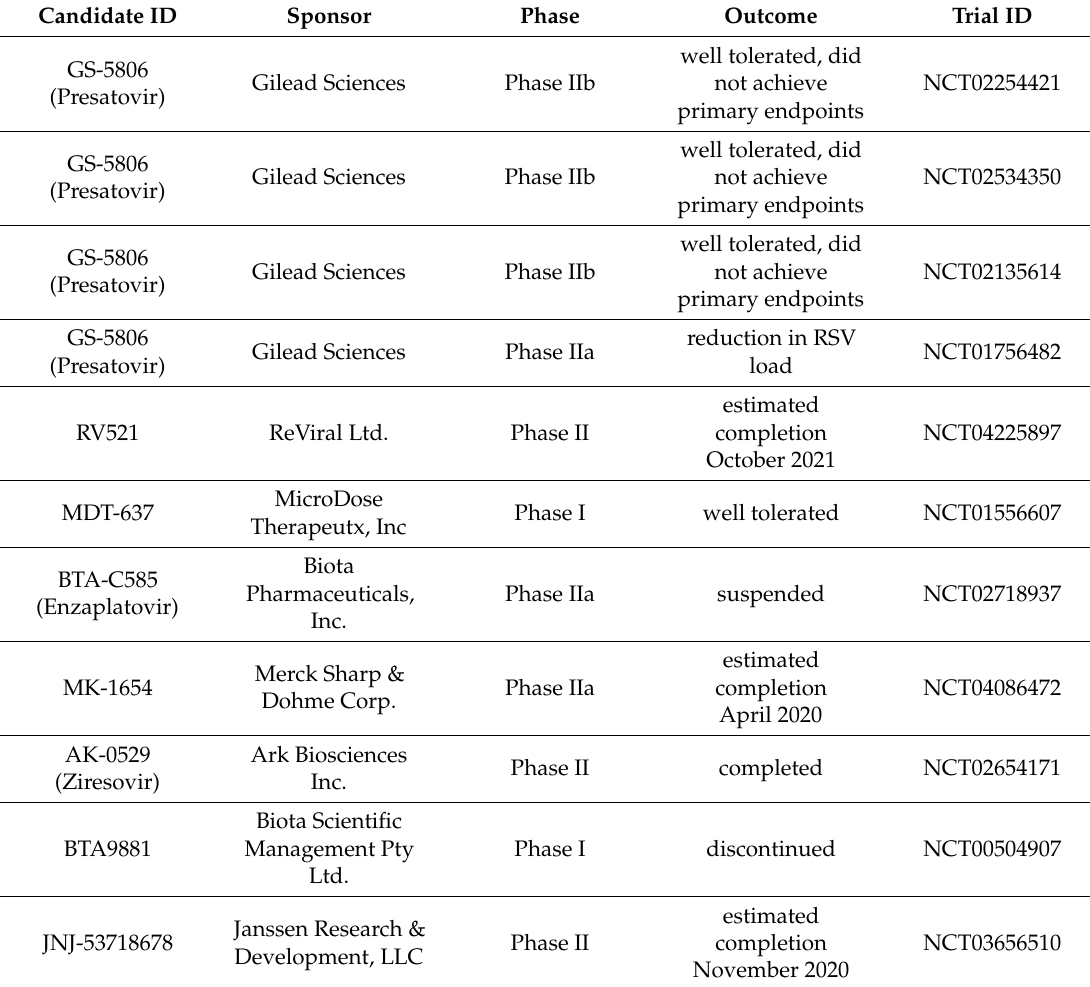
Table 1. Small molecule RSV entry inhibitors in clinical